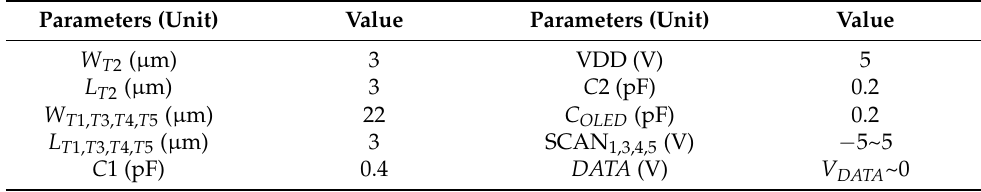
Table 1. Design parameters of the circuit.